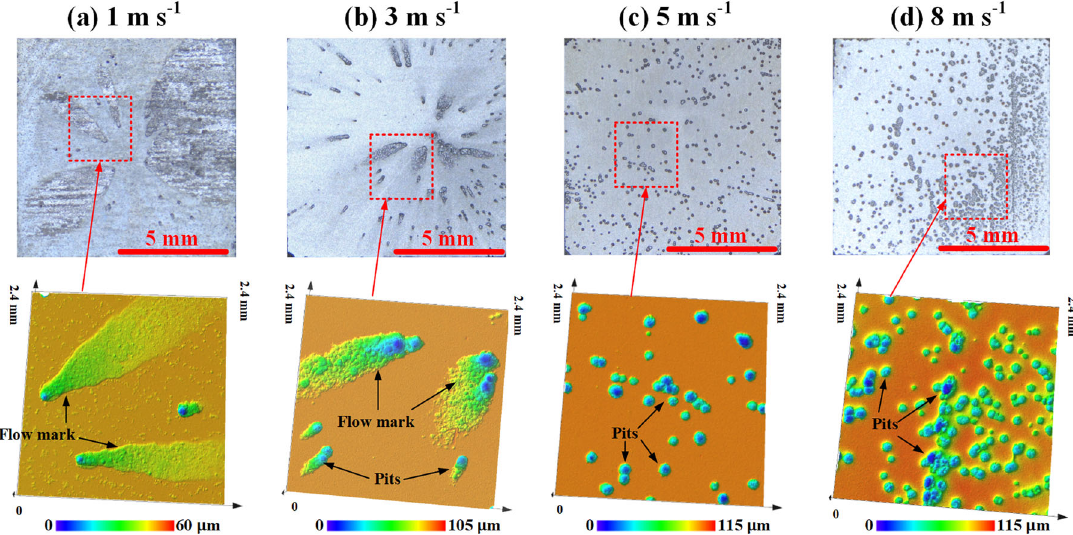
Fig. 9 Photos and local 3D pro fi les of the steel samples after erosion − corrosion experiments (with rust layer removed) at different fl ow velocities. a 1 m s − 1 , b 3 m s − 1 , c 5 m s − 1 , and d 8 m s − 1